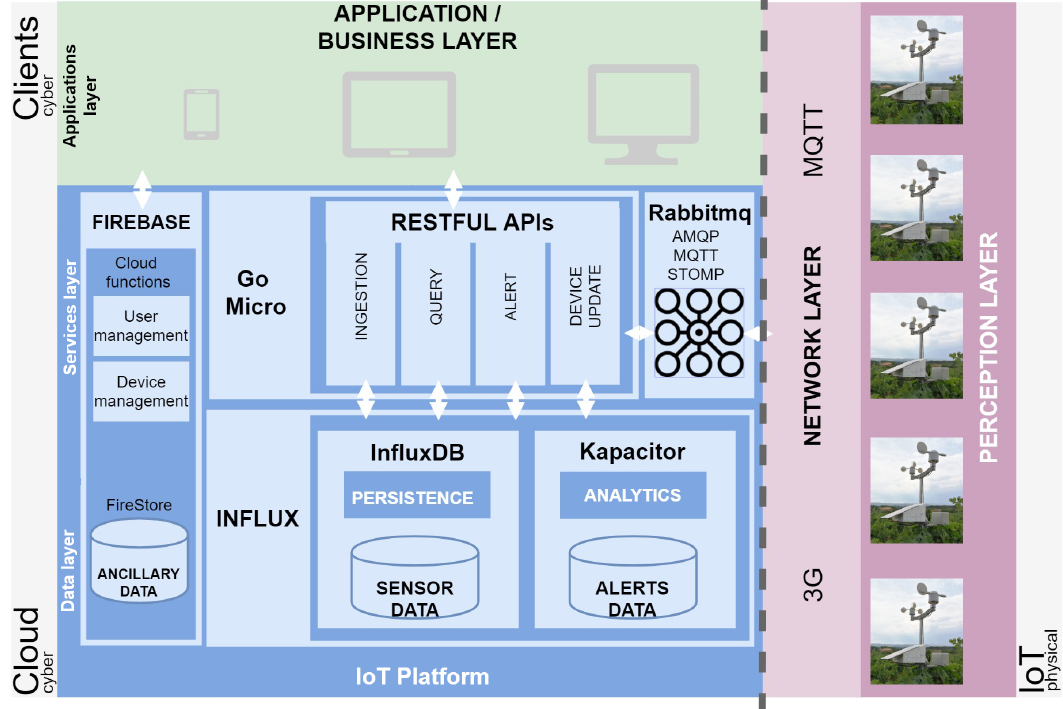
Figure 4. A general overview of the full system from a technological point of